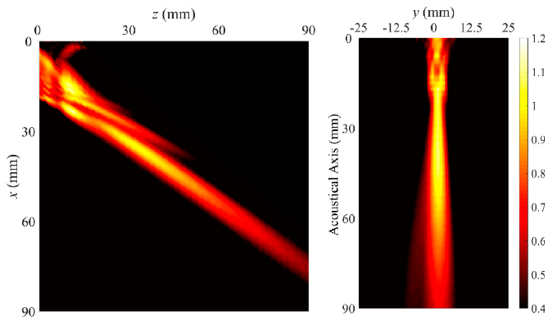
Figure 16. Measured beam profiles of the leaky Lamb wave excited at d = 330 mm (1.5 mm thickness and 15 mm width, 1.0 MHz center frequency).